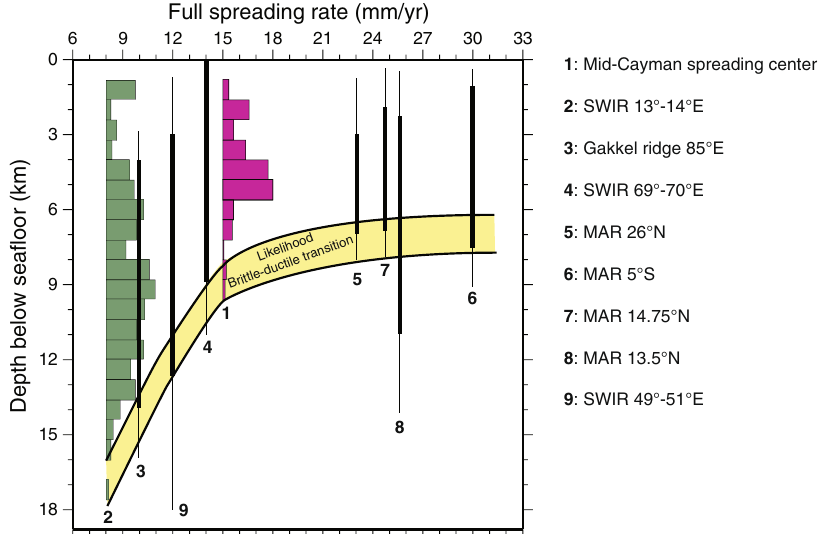
Fig. 7 Observed brittle thickness at mid-ocean ridges as inferred by the micro-seismicity distribution with depth for various spreading rates. Depth is given using the sea fl oor elevation as a reference. Histograms show the vertical distribution of micro-seismicity with depth 51 . Bold lines show the depth distribution of the majority of micro-earthquakes while adjacent thin lines represent isolated micro-earthquakes 53,65 – 70 . 1 , 2 : Grevemeyer et al., 2019 51 ; 3 : Korger and Schlindwein, 2014 68 ; 4 : Katsumata et al., 2001 53 ; 5 : deMartin et al., 2007 65 ; 6 : Tilmann et al., 2004 66 ; 7 : Grevemeyer et al., 2013 67 ; 8 : Parnell- Turner et al., 2017 69 ; 9 : Yu et al., 2018 70 . Modi fi ed from Grevemeyer et al., 2019 51